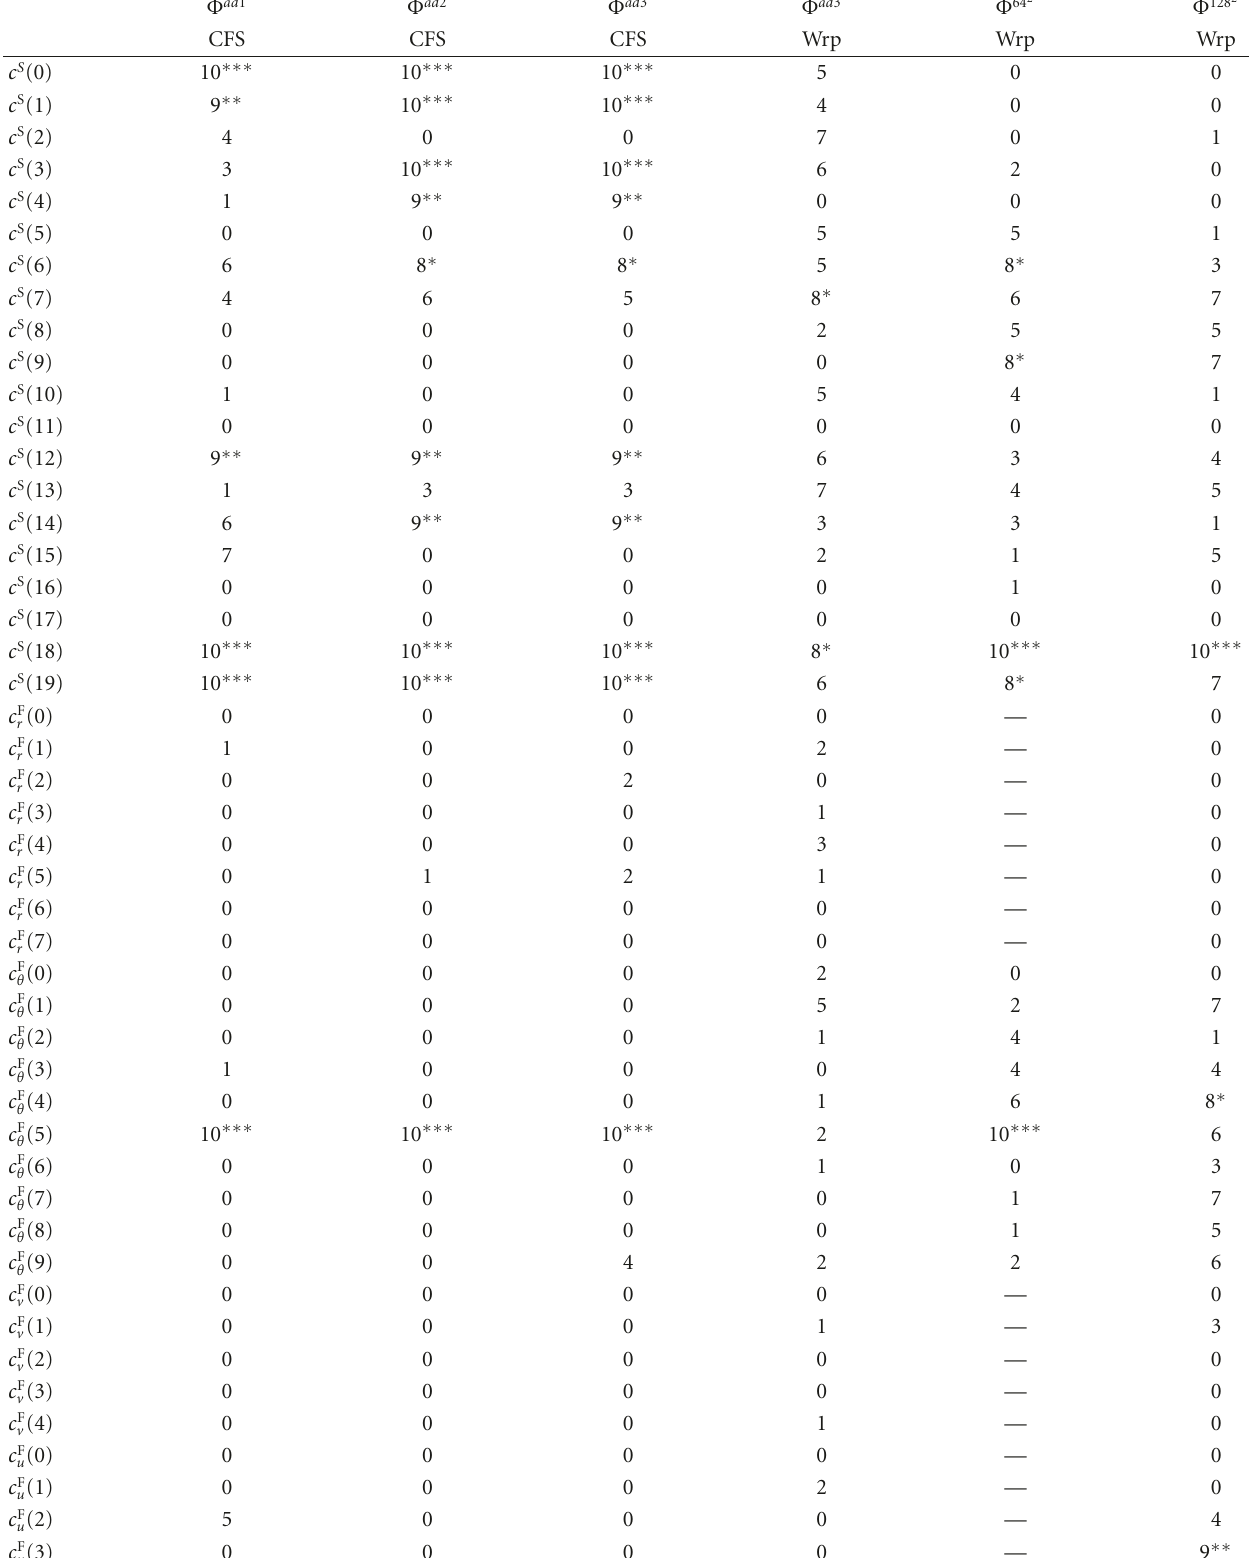
Table 3: Selected stripe and fourier features for the 6 FSS methods marked in bold face in Table 2. The features are selected using a CFS-based method and a wrapper-1-NN-based method and a 10-F cross-validation. The 10-time, 9-time, and 8-time selected features are marked with ∗∗∗ , ∗∗ , and ∗